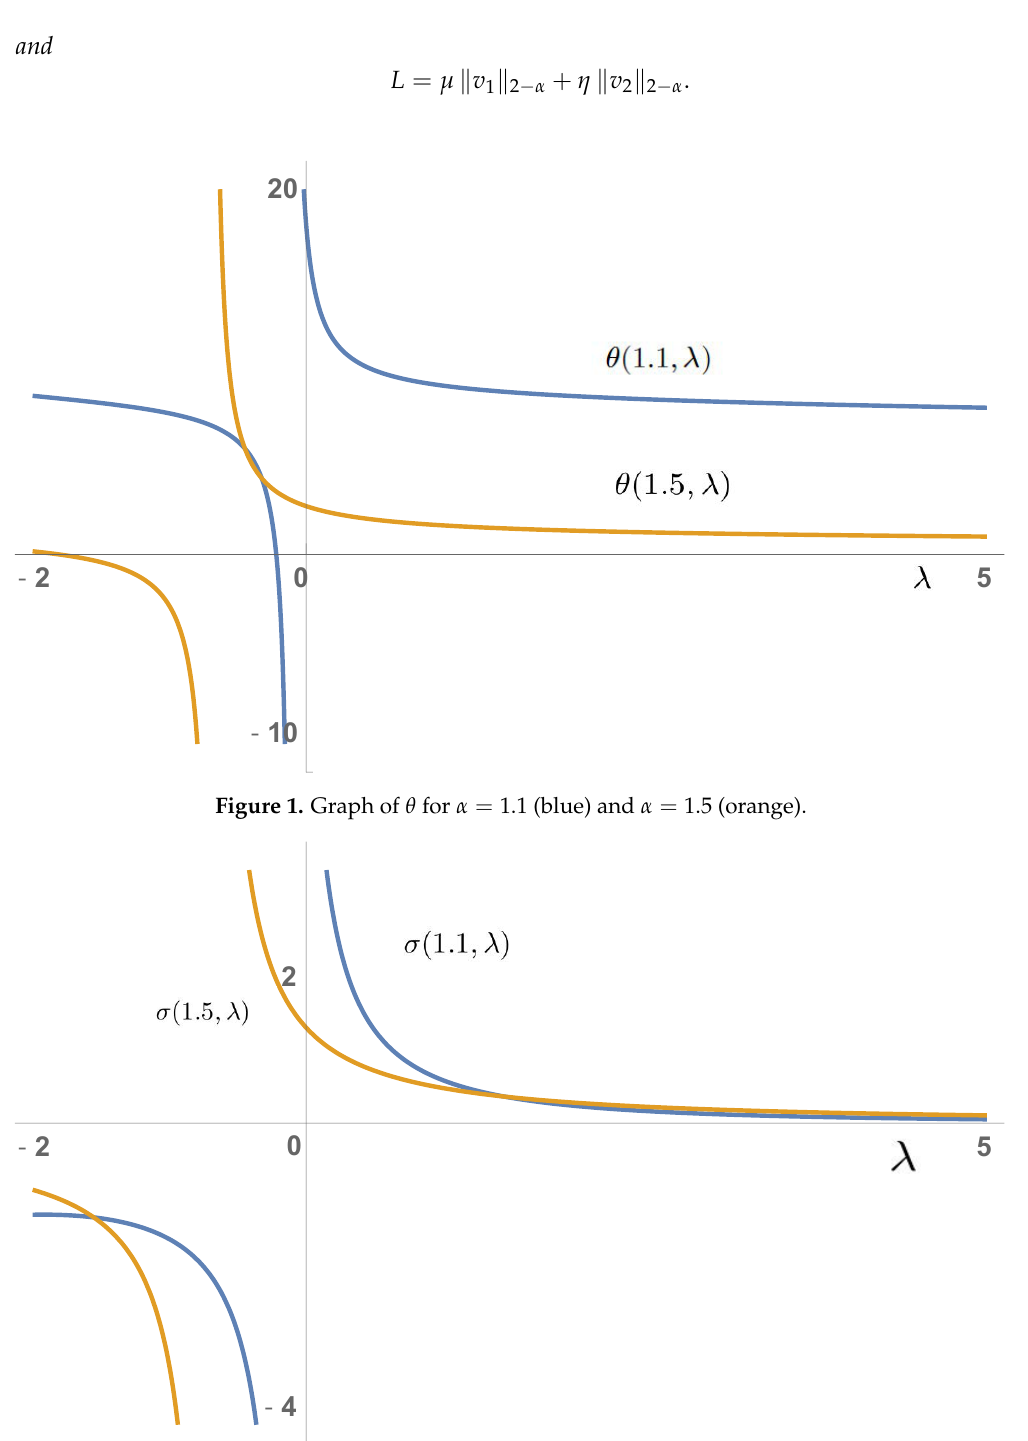
Figure 2. Graph of σ for α = 1.1 (blue) and α = 1.5